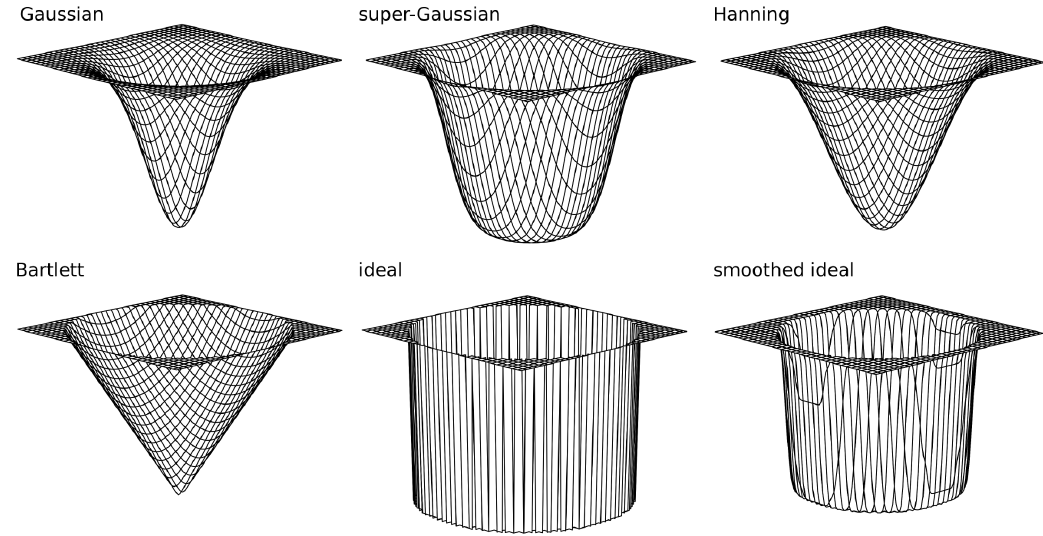
Figure 4. Various filters used for performance